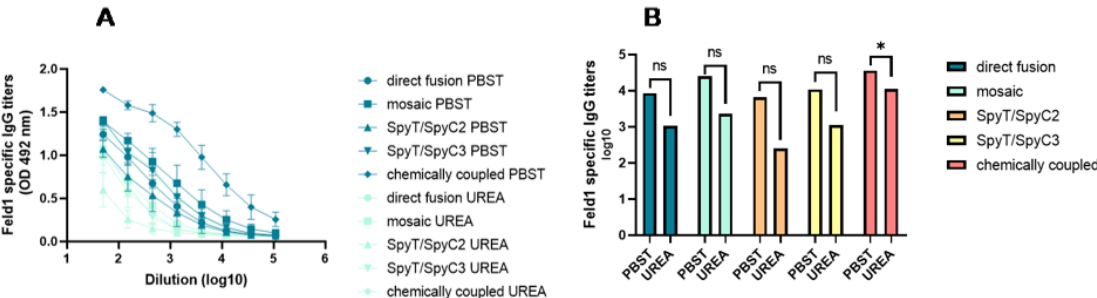
Figure 8. Avidity antibody detection after vaccination with PVY–Fel d 1 variants. ( A )—Fel d 1-specific IgG titers for the groups vaccinated with PVY–Fel d 1 variants on Day 42 measured at OD 492 . After serum incubation, one plate was treated with PBS with 0.05% Tween 80, and the other plate was treated with 7 M urea in PBS with 0.05% Tween 80; ( B )—Log 10 values (mean ± SEM) of Fel d 1-specific IgG titers (shown in a) for the group vaccinated with PVY–Fel d 1 vaccine variants. Statistical analysis was performed using Student’s t test in GraphPad Prism 9.0. Vaccine groups n = 5. One representative experiment was performed. A value of p > 0.05 was considered statistically significant (ns – not significant; * p < 0.01).